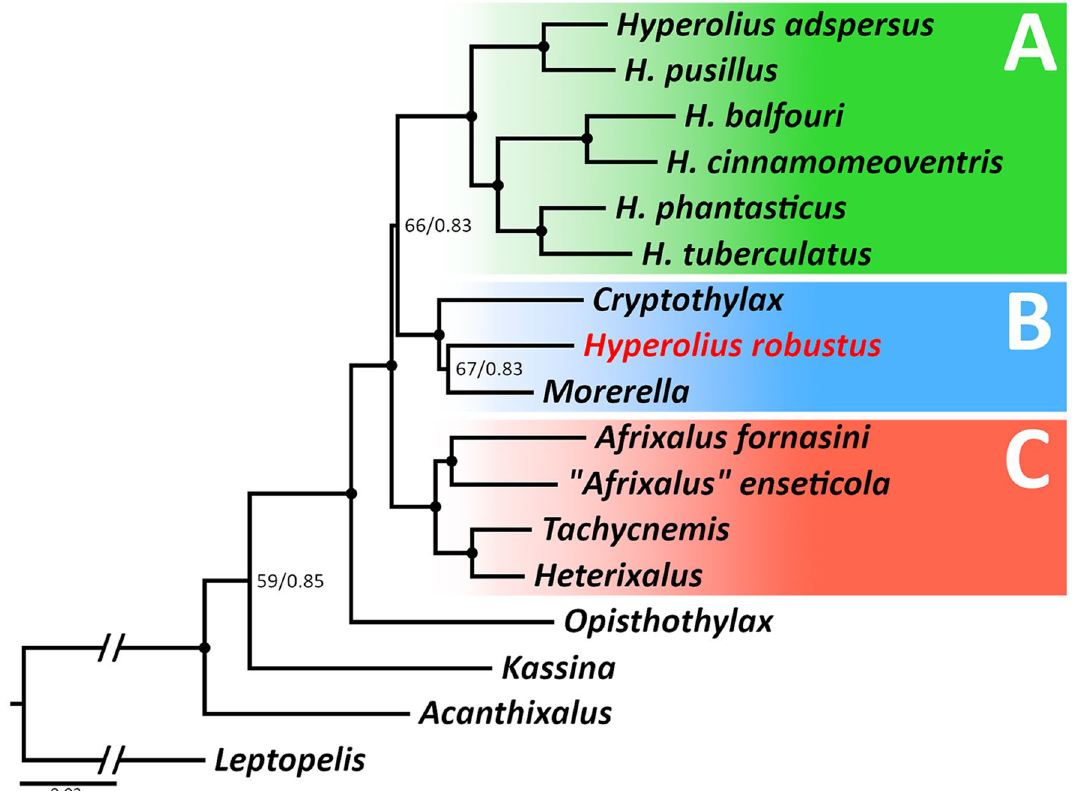
Figure 2. Phylogenetic tree of hyperoliid frogs with a focus on the subfamily Hyperoliinae. The majority rule consensus tree inferred from Bayesian analyses of four nuclear and one mitochondrial marker (complete data set). Dots at nodes represent high supports (ML bootstrap ≥ 70/Bayesian posterior probability ≥ 0.95) while numbers show support values for nodes with a lower support. Sequence GenBank accession numbers are provided in Supplementary Table